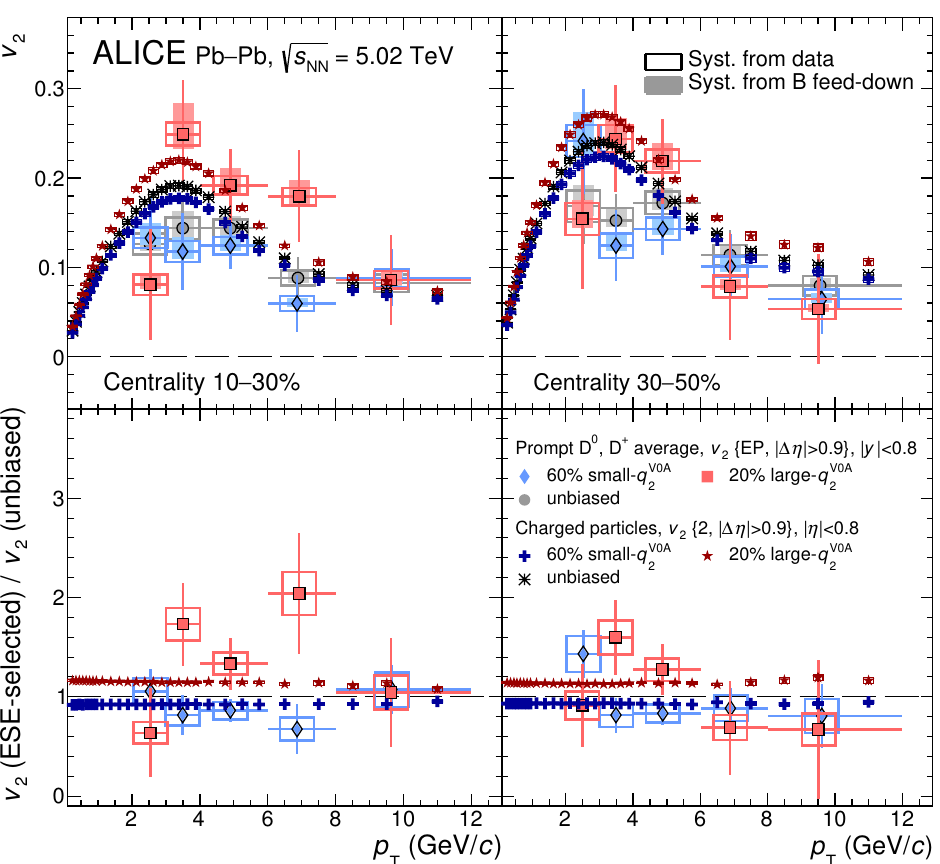
Figure 9 . Top panels: average of D 0 and D + v 2 as a function of p T for Pb-Pb collisions at p s = 5 : 02 TeV in the small- q V0A , large- q V0A (see text for details) and unbiased samples, in the 2 2 NN 10{30% (left) and 30{50% (right) centrality classes. The charged-particle v 2 obtained at the same energy, centrality classes and ESE samples are superimposed for comparison. Bottom panels: ratios of the measured v 2 in the ESE-selected classes to the one obtained from the unbiased